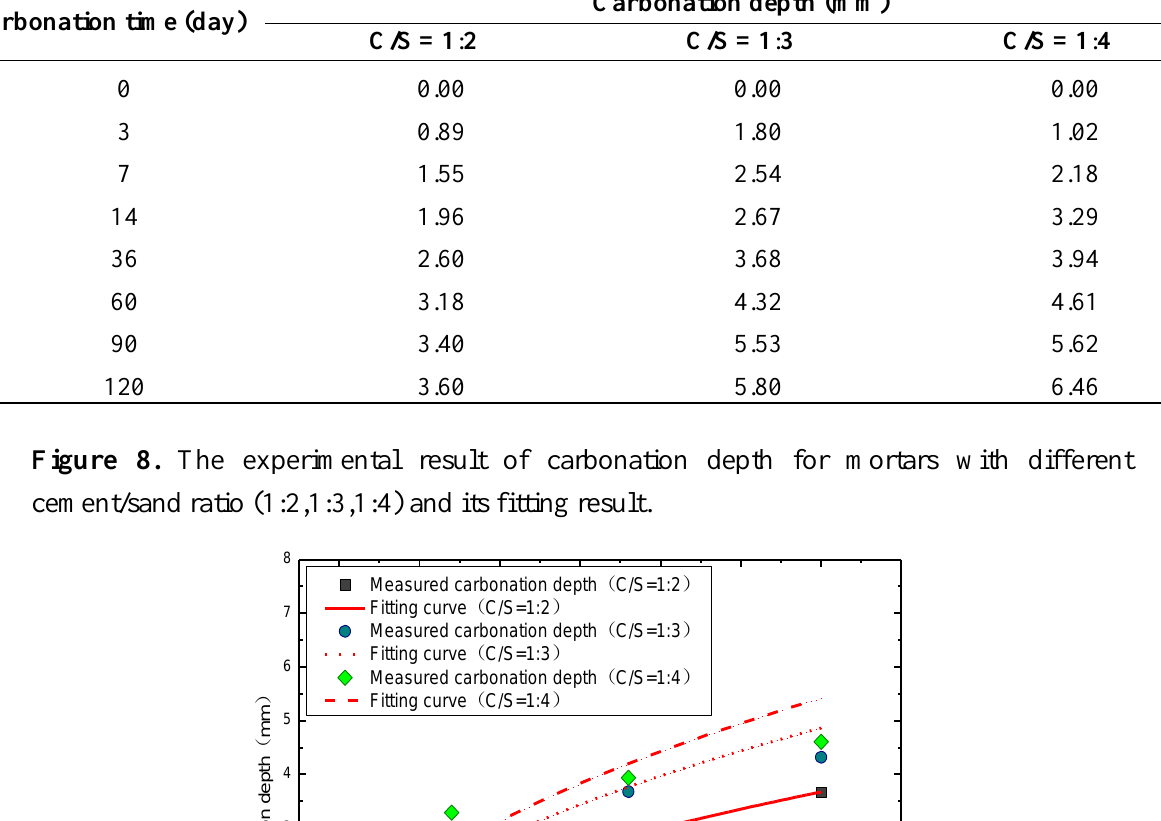
Table 2. The average carbonation depth for mortars with different cement/sand ratio (1:2,1:3,1:4). Carbonation time (day)